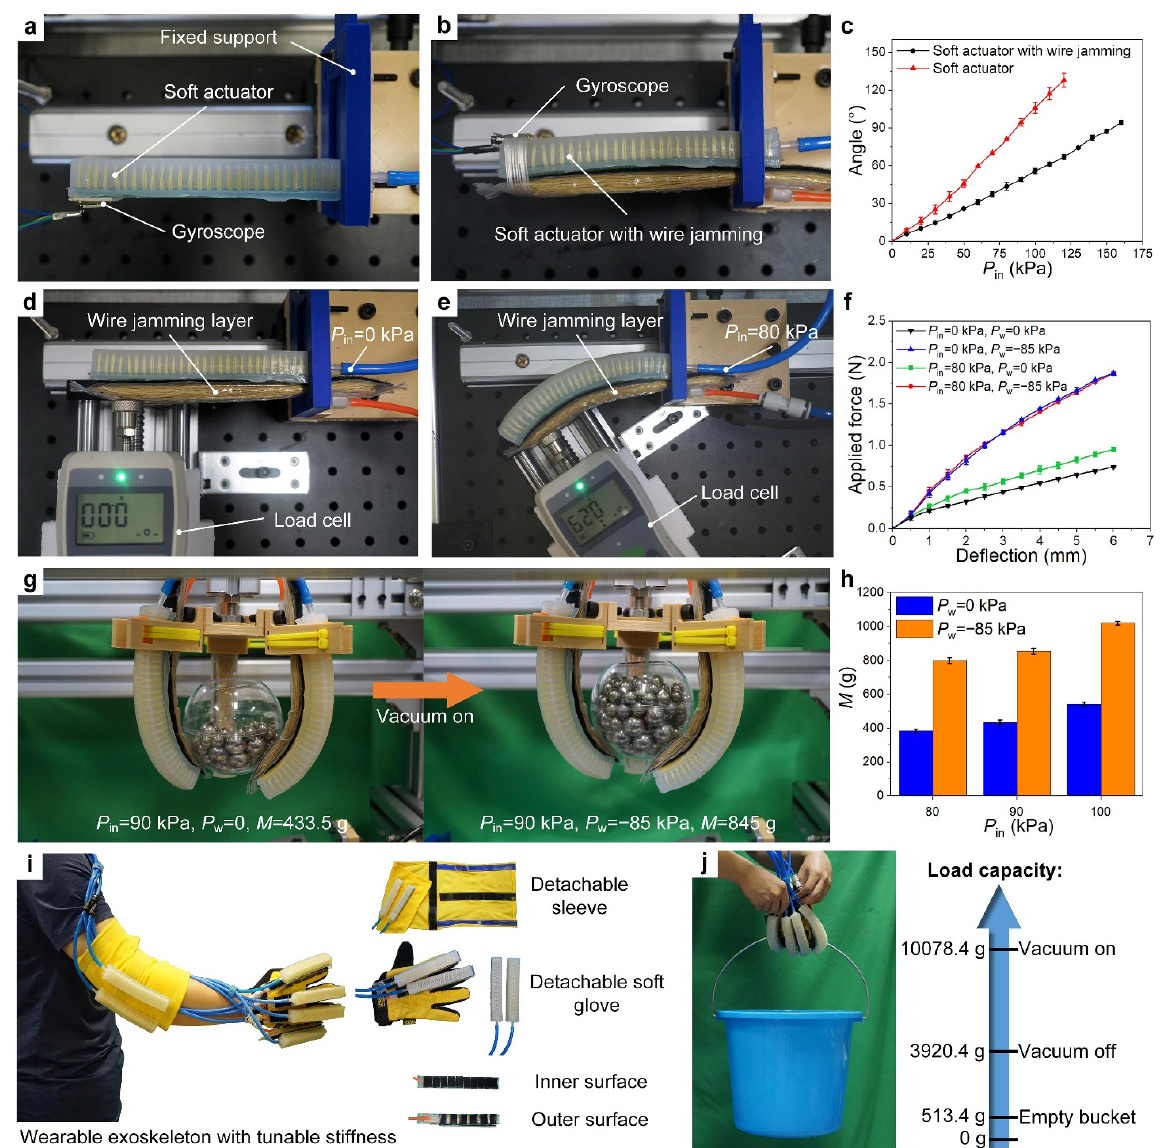
Figure 5. Applications of an assembled soft actuator with tunable stiffness. ( a , b ) Experimental setup for a single soft actuator and an assembled soft actuator installed with a wire jamming structure, respectively. A nine-axis gyroscope (JY901S, WitMotion Co. Ltd., Shenzhen, China) is used to meas- ure the bending angle with different inflation pressure. The gyroscope is attached to the tip of the soft actuator. ( c ) Angle versus positive air pressure P in curves of the soft actuator before and after assembly. ( d , e ) Bending stiffness experiments of the assembled soft actuator under two different positive air pressures. ( f ) Applied force versus deflection curves of the bending stiffness experi- ments. ( g ) Demonstration of the grasping process of the soft robotic gripper. ( h ) Comparison of maximum grasping mass at different positive air pressures. ( i ) An application example of a weara- ble exoskeleton, which only shows the wearing effect on the right arm. ( j ) The experiment of load capacity of a detachable soft glove, where the positive air pressure is 165 kPa, and the vacuum pres- sure is − 85 kPa. To further demonstrate the versatility of the soft assembly actuator with tunable stiff- ness, we developed a soft robotic gripper, which consists of three assembled soft actua- tors. The experimental scheme is to grasp a hollow plastic carrier at a confined positive air pressure, then set a specified vacuum pressure and finally increase the overall mass